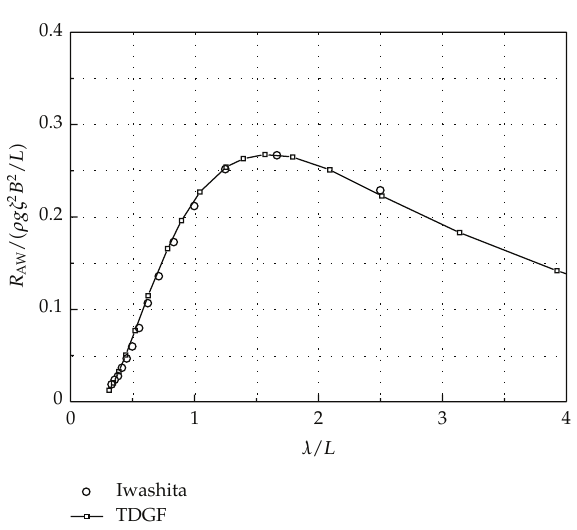
Figure 6: Di ff raction-added resistance: F n (cid:7) 0 .